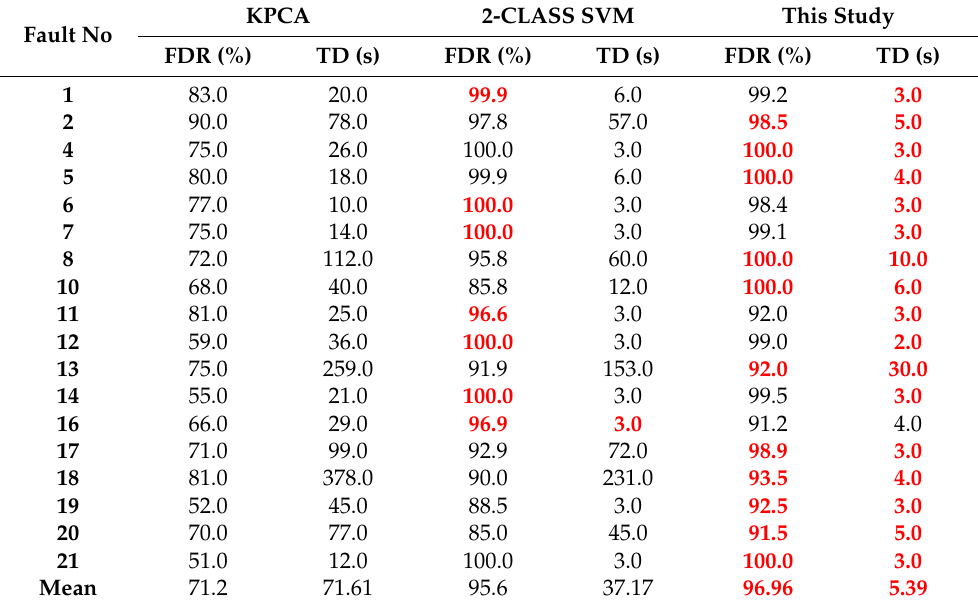
Table 2. Comparison of the FDR and TD of KPCA, 2-CLASS SVM [34], and the methods of this